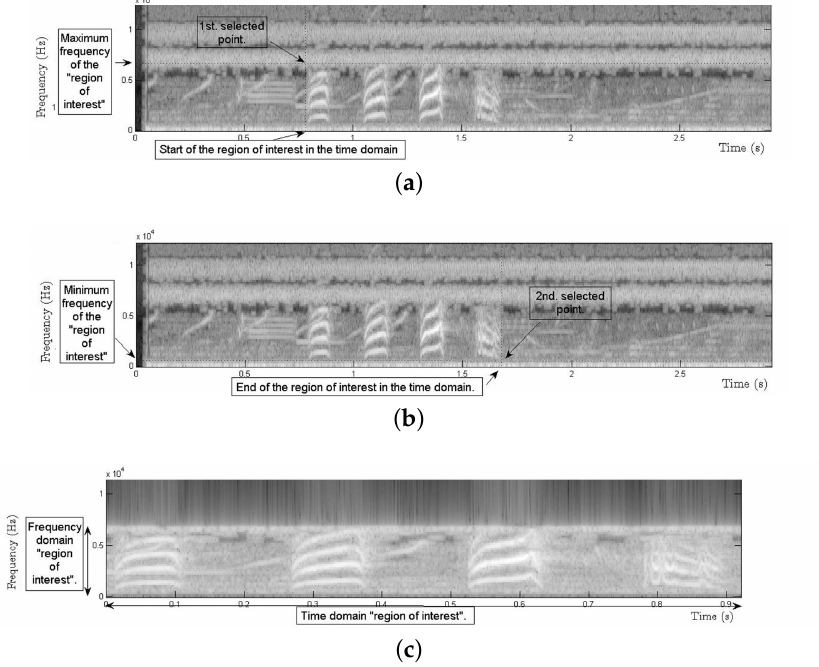
Figure 5. Example of by-observation vocalization extraction: ( a ) first selected point; ( b ) second selected point; and ( c ) region extracted by the user